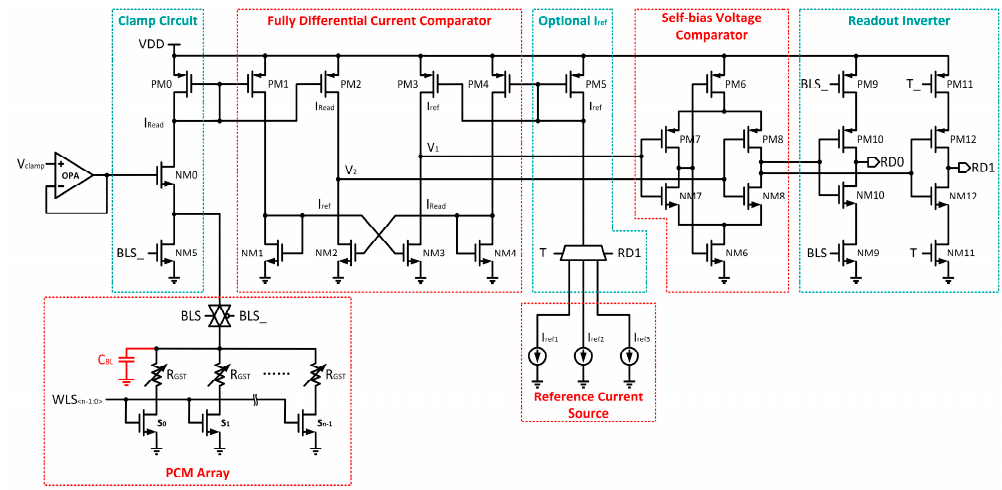
Figure 9. Fully differential high-speed readout circuit with an optional reference current source. Figure 9. Fully di ff erential high-speed readout circuit with an optional reference current